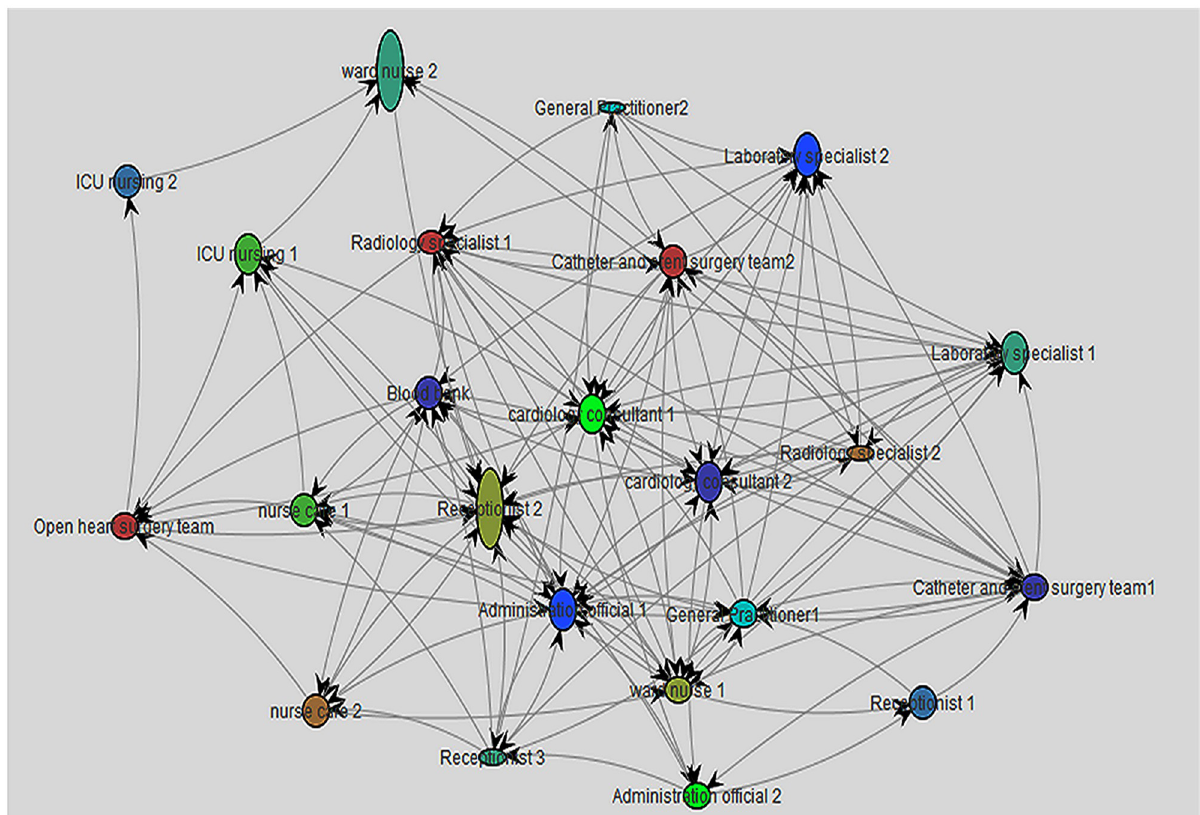
Fig 27. Social network of the hospital originators with the handover of work